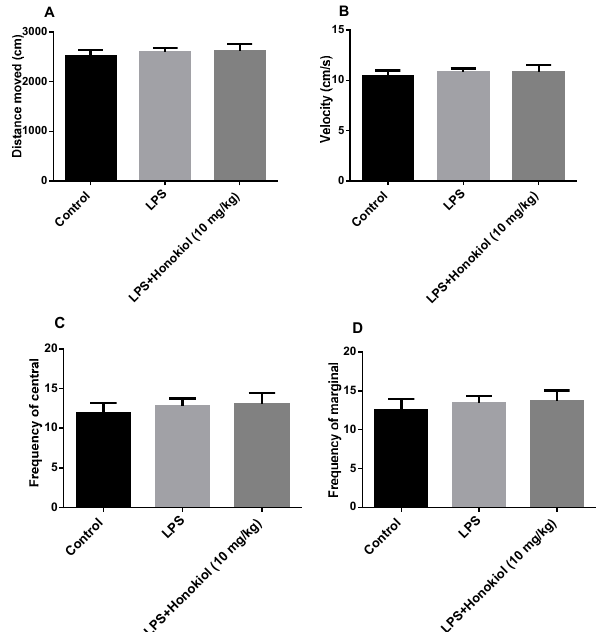
Figure 1. The effects of lipopolysaccharide (LPS) and honokiol on autonomous activity. ( A ) The distance moved. ( B ) The velocity of movement. ( C ) The central region dwelling frequency. ( D ) The marginal region dwelling frequency. Data are expressed as mean ± SEM ( n = 10/group). The results showed no difference between the different groups.